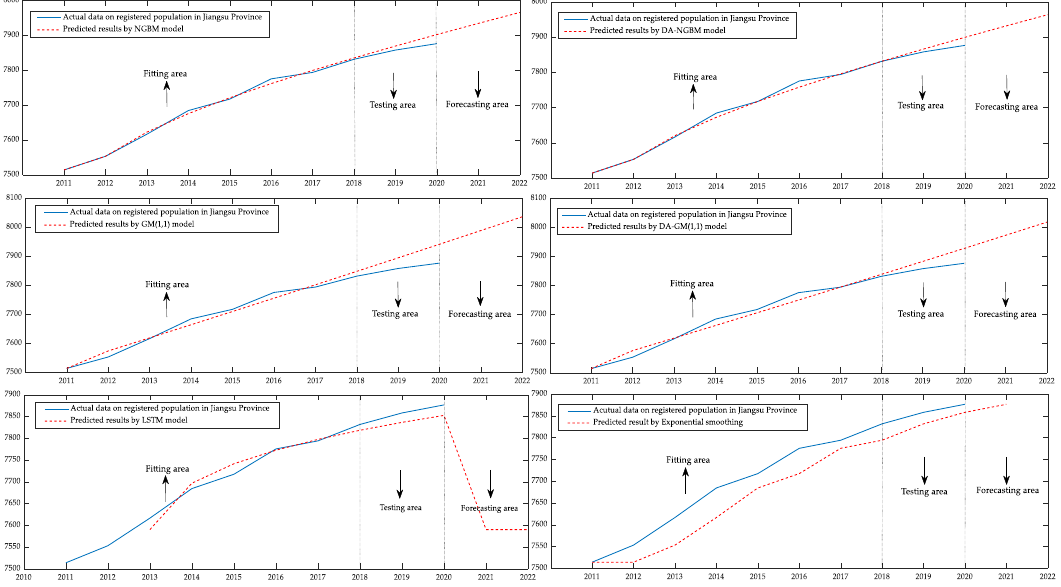
Figure 4. Comparison of the fitting and prediction curves of registered population in Jiangsu Province from 2011 to 2022.